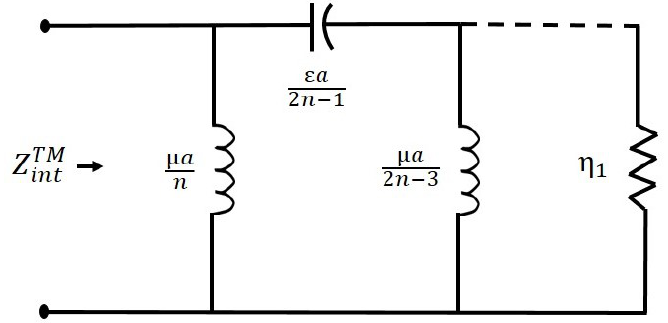
Figure 3. Representation of internal impedance of the excited TM n mode in the cylindrical nanowire forming a ladder